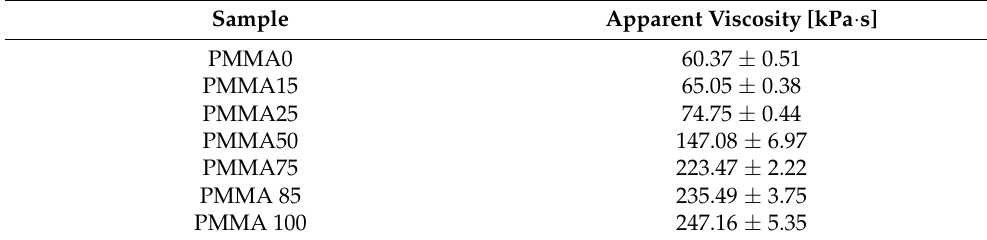
Table 1. Apparent viscosity calculations from Equation (1) using ∆ p values measured during